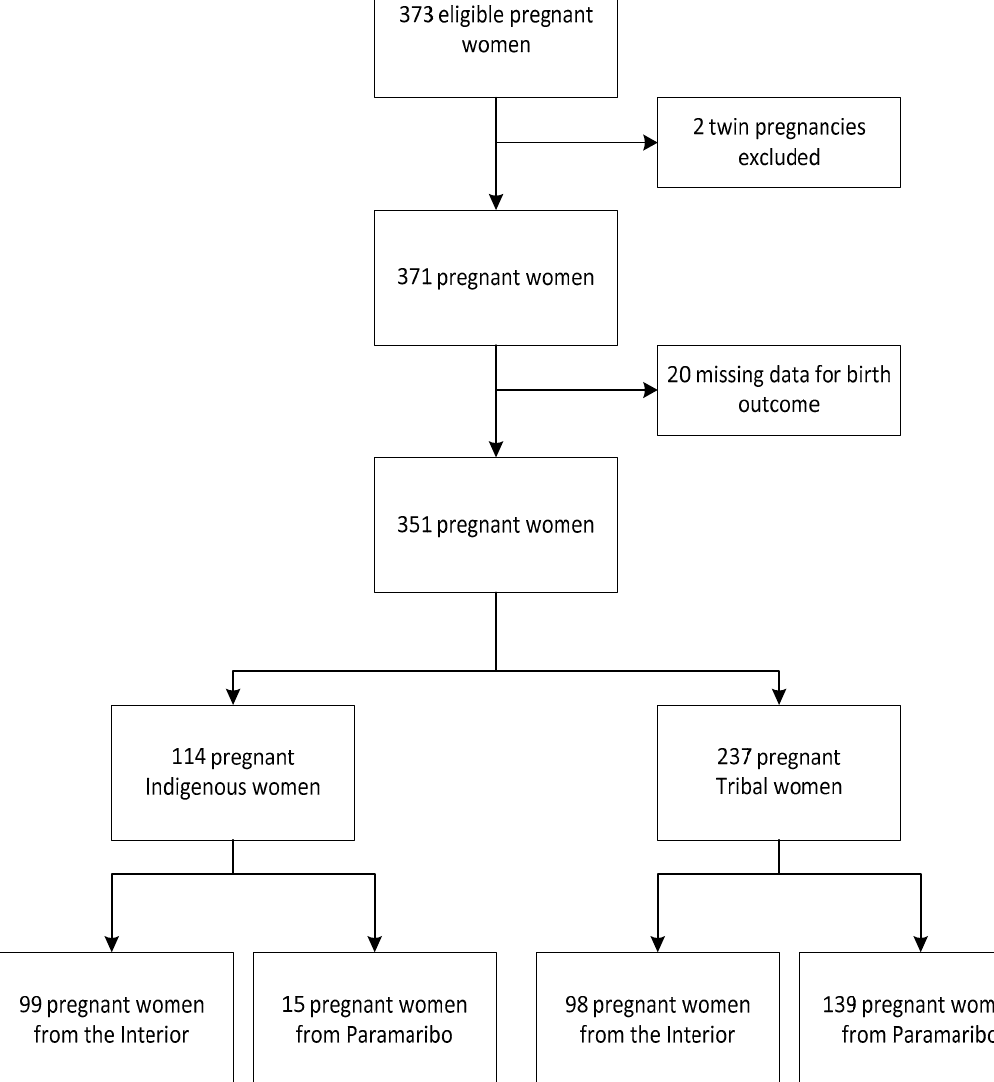
Figure 1. Enrollment flowchart of the study